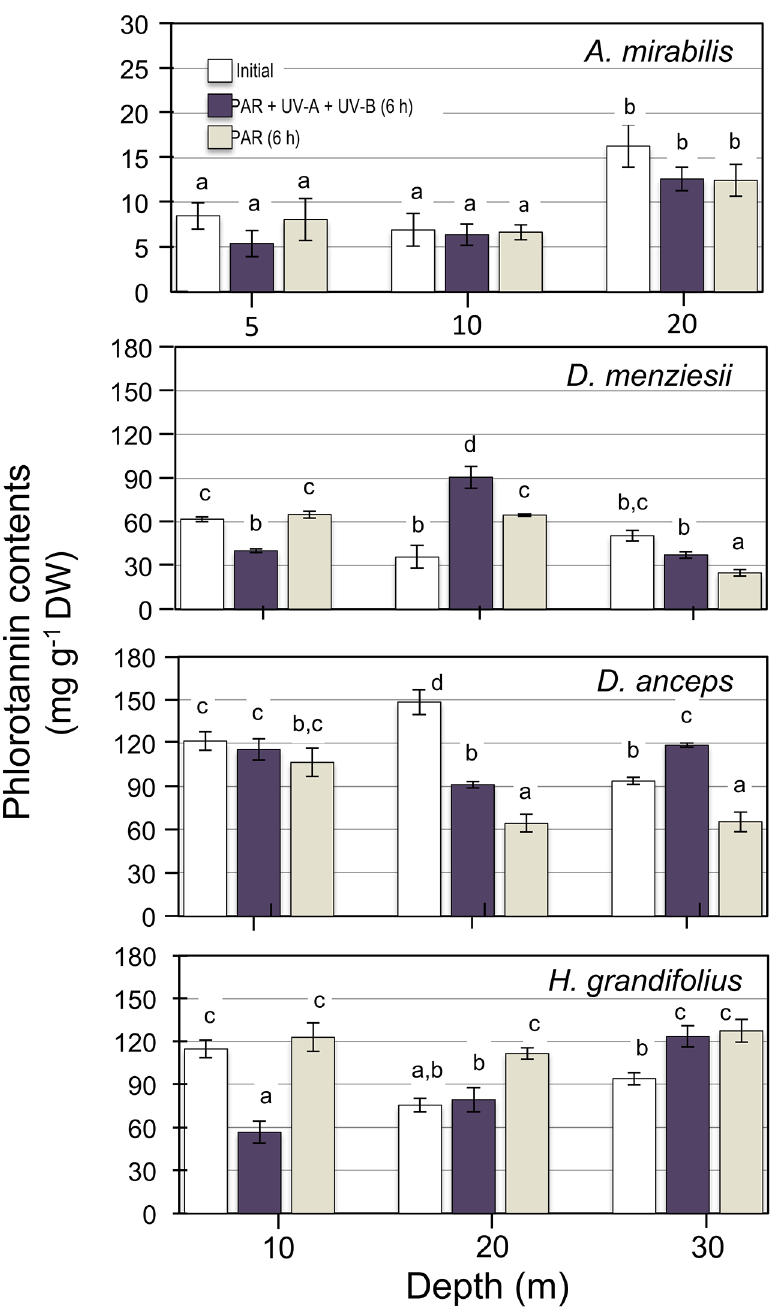
Fig 6. Effect of UV exposure on the concentration of phlorotannins measured in four brown algae collected at different depth in Fildes Bay. Algae were exposed for 6 h to PAR+UV-A+UV-B and PAR conditions (20 μ mol m -2 s -1 for PAR, 3 W m -2 for UV-A and 0.25 W m -2 ). Initial is the time cero before the 6 h exposure to UV radiation. Values are means ± S.D., n = 3. Similar letters connect homogeneous mean groups for each species after two-way ANOVA and Tukey ’ s